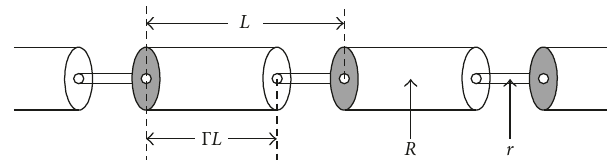
Figure 2: Tubes-in-series model (where 𝑅 is the radius of the coarse tube, 𝑟 is the radius of the thin tube, 𝐿 is the total length of a set of coarse and thin tubes, and Γ is the fractional length of the pore bodies) [30].